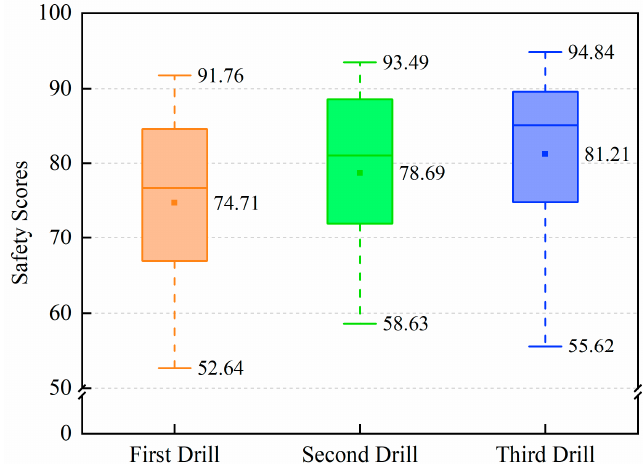
Figure 11. Safety scores of three drills.